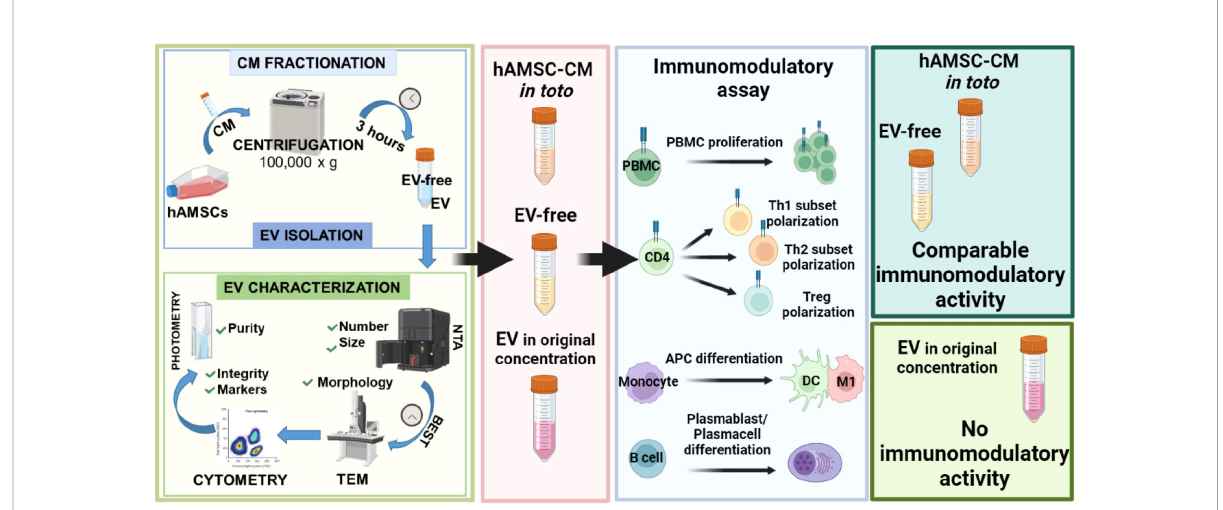
FIGURE 7 Summary fi gure hAMSC secrete factors able to modulate the immune system. This study demonstrates that the EV fraction of the hAMSC secretome has a negligible immunomodulatory effect while the EV-free fraction is the active